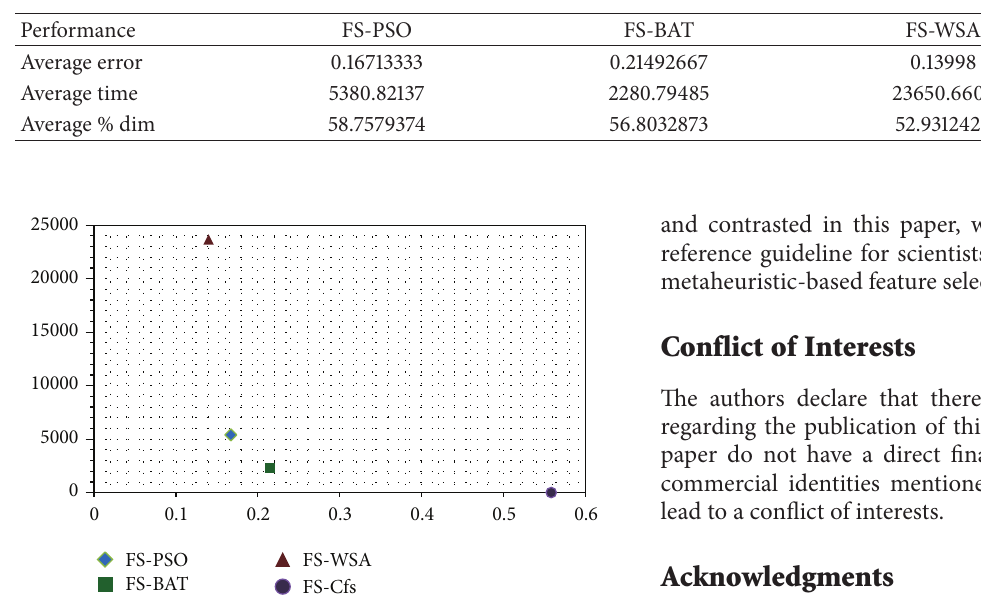
Table 9: Comparison of overall performances of different Swarm-based feature selection algorithms.